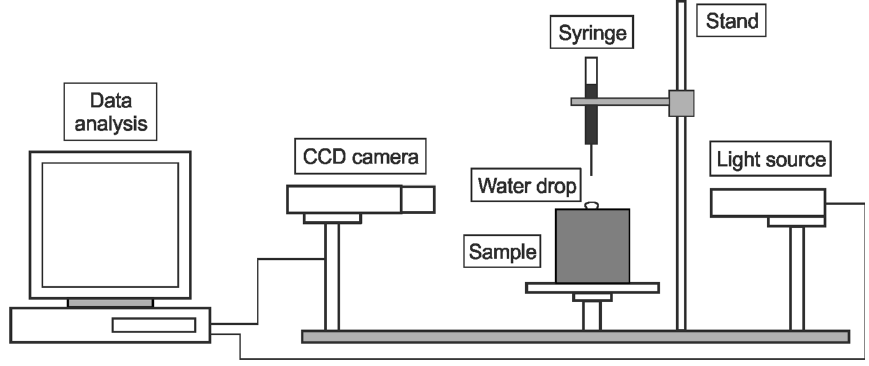
Fig. 4 Equipment used in contact angle measurement.